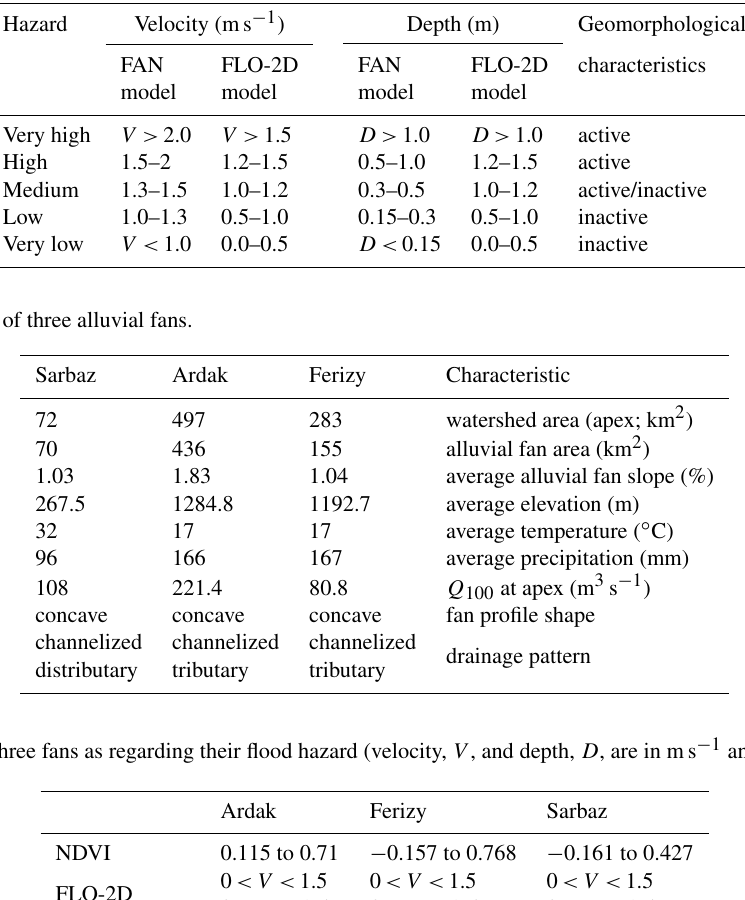
Table 2. Flood criteria for delineating hazard maps.